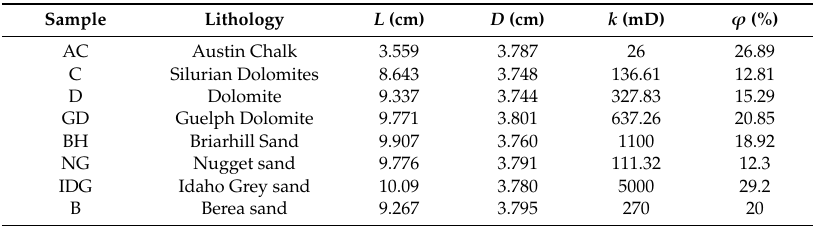
Table 2. Dimensions and petrophysical properties of core samples.